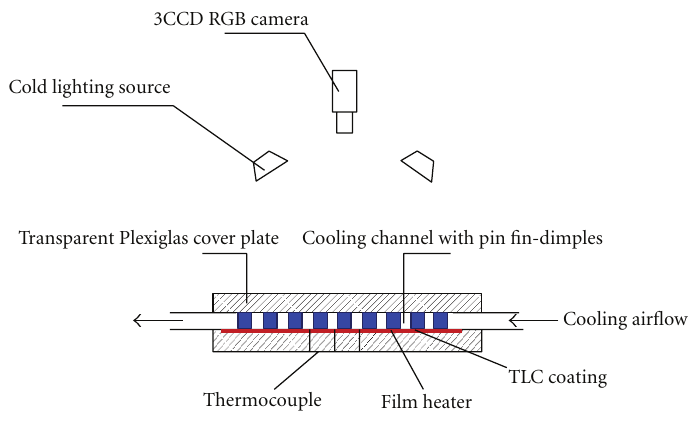
Figure 11: Experimental Schematic for the pin fin-dimple channel heat transfer measurement with the steady TLC thermography.